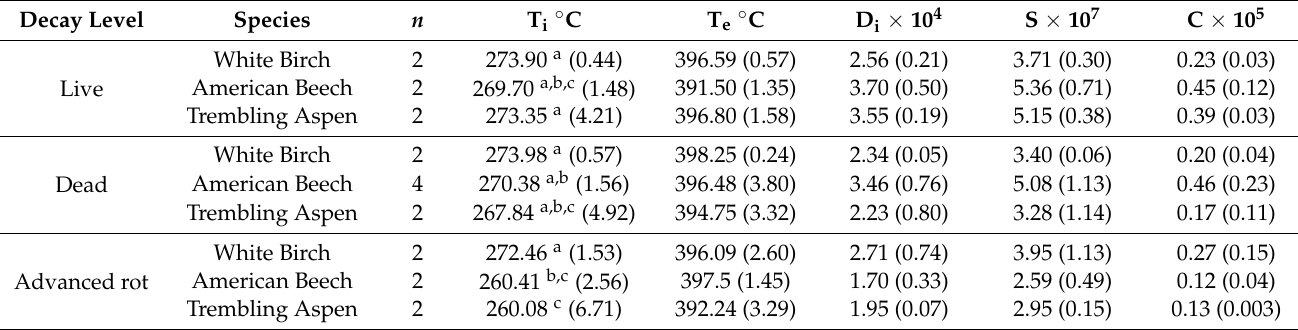
Table 4. Combustion characteristic parameters of hardwoods at different decay level. n = number of samples. Values in parentheses show standard